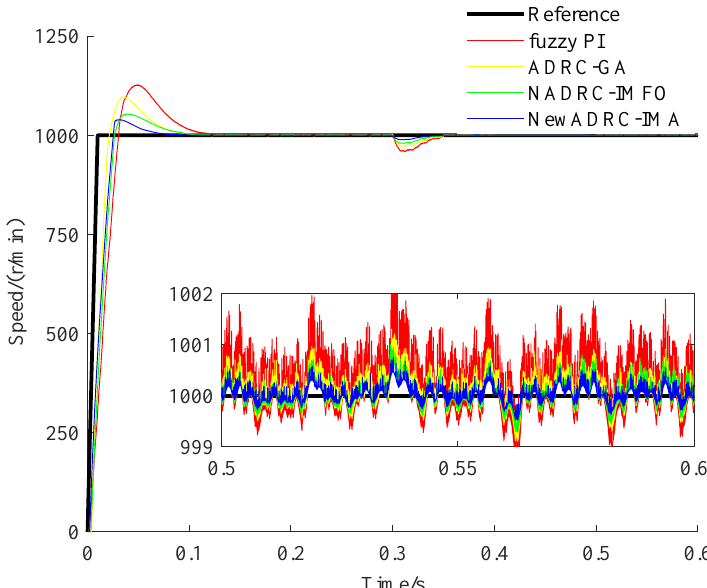
Figure 10. The speed curves under the second PMSM velocity control practical case.